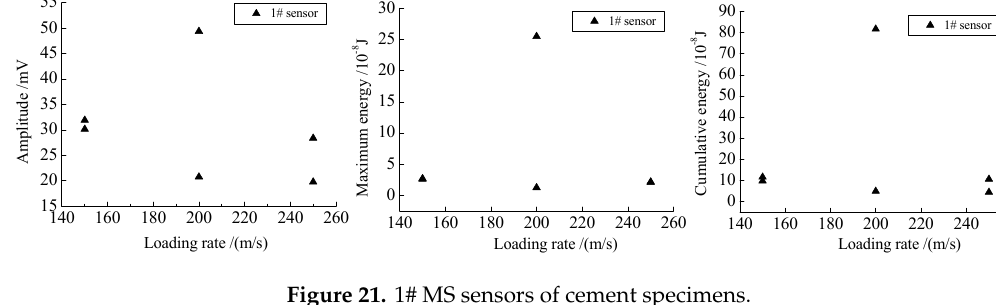
Figure 21. 1# MS sensors of cement specimens.